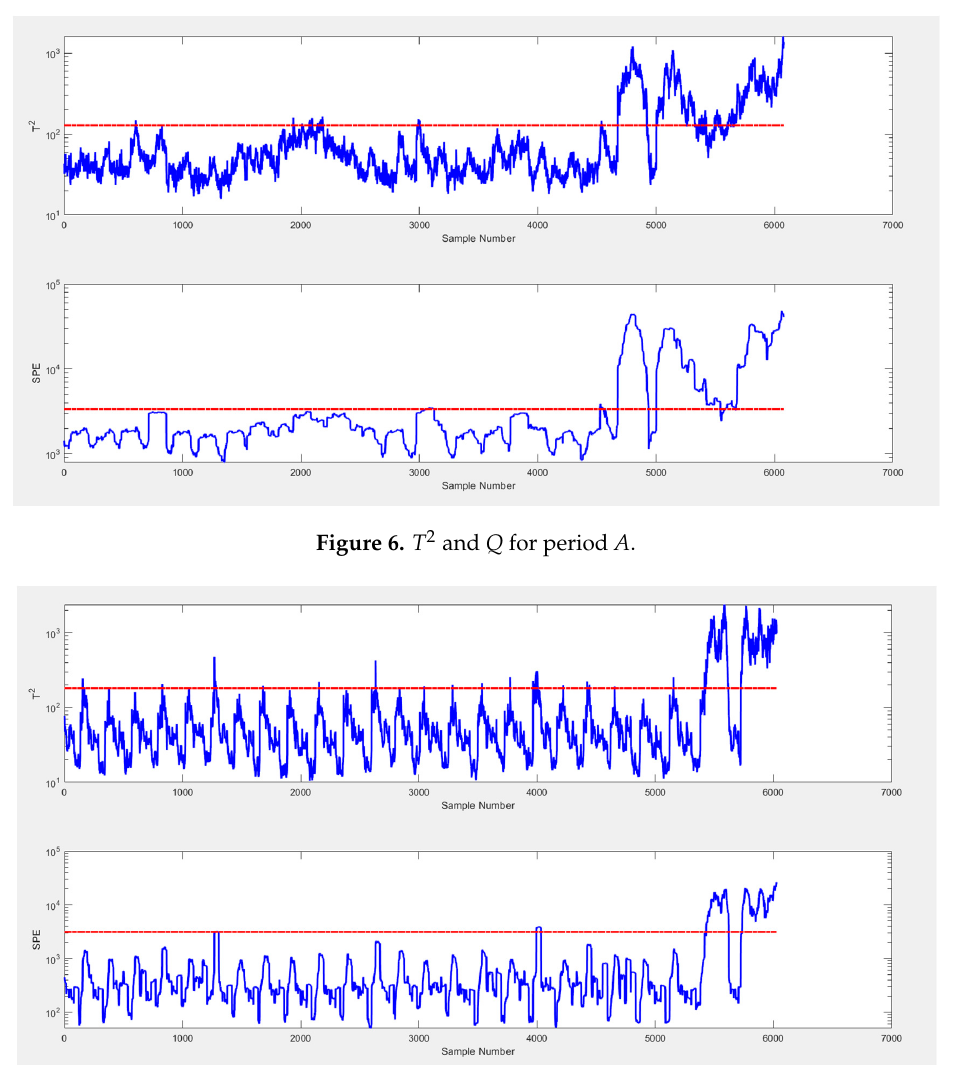
Energies 2020 , 13 , x FOR PEER REVIEW